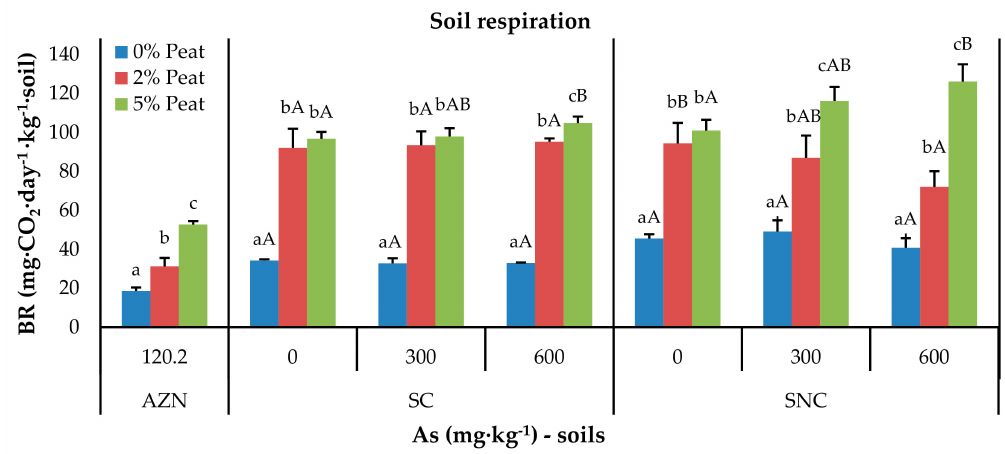
Figure 1. Basal respiration rate (BR) for soil samples with di ff erent treatments. Lowercase letters indicate statistically significant di ff erences for each treatment with di ff erent peat additions; and capital letters among the di ff erent treatments with As for the same peat content (Kruskal-Wallis test, p < 0.05).